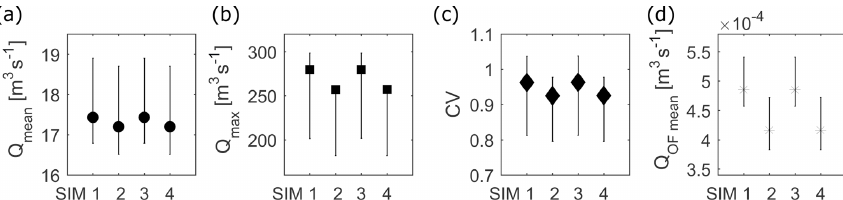
Figure 6. Comparison of the hydrological response of the basin in the four simulations: (a) mean annual discharge Q mean , (b) annual flood Q max , (c) coefficient of variation CV of the hourly discharge at the basin outlet, and (d) mean annual overland flow runoff over the basin Q OFmean . Markers indicate mean values and the lines the interval between the 25th and 75th percentile of the distribution from hourly data over the entire simulation period.